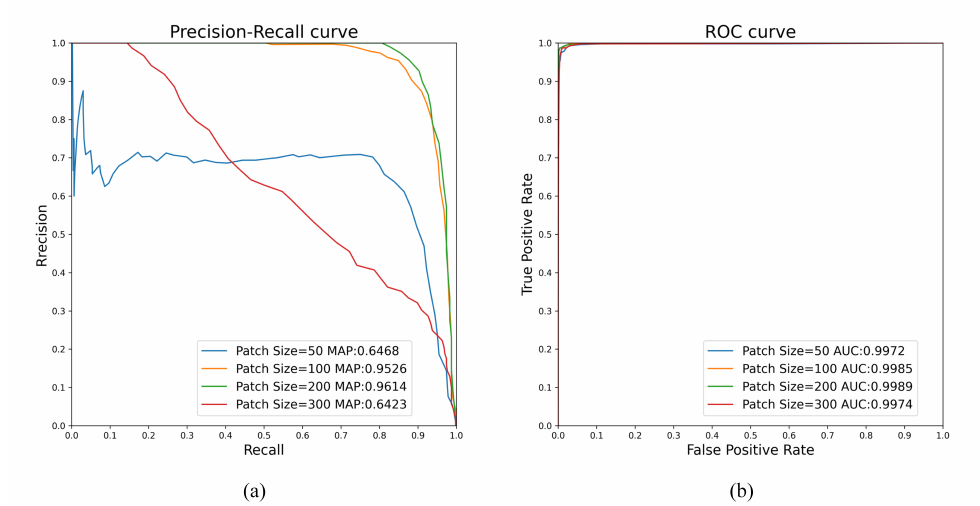
Figure 13. Influence of patch size on AUC and mAP values in the P-RPCA method. ( a ) PR curve, ( b ) ROC